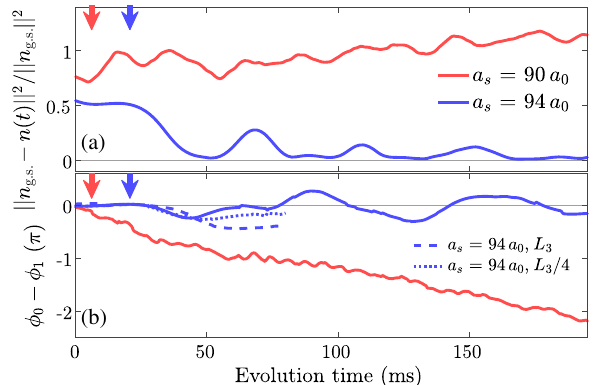
FIG. 2. Overlap of the calculated dynamical state with the ground state. (a) Time evolution of the density difference k n − n ð t Þk 2 = k n k 2 , where n ð t Þ is the dynamical density, g : s : g : s : n . is the ground state density, and k (cid:2) (cid:2) (cid:2) k is the Euclidean norm. g : s : We observe little density overlap for the isolated droplets (red) and (except for a residual breathing mode) high density overlap for the coherent droplet state (blue). (b) Time evolution of the phase difference ϕ 0 − ϕ 1 between the central droplet and its nearest neighbor for the dynamical simulation. For the coherent droplet the phase difference caused during the formation process is rapidly compensated leading to a vanishing phase difference between the two neighboring droplets. On the other hand, the phase difference of isolated droplets increases almost linearly after the formation, which is due to their difference in chemical potential. Including three-body losses we see a constant (exper- imentally measured L 3 , dashed line) or slowly decreasing ( L 3 = 4 , dotted line) phase difference during the lifetime of the droplets. The arrows indicate the respective formation time of the droplets for the two scattering